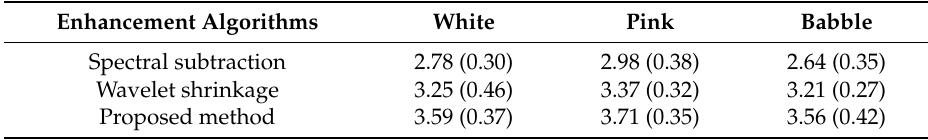
Figure 4. The time-domain waveforms and the spectrograms of the radar speech “1-2-3-4-5-6”. ( a , e ) are the original radar speech; ( b , f ) are enhanced speech obtained by the spectral subtraction; ( c , g ) are enhanced speech obtained by the wavelet shrinkage; ( d , h ) are enhanced speech obtained by the proposed algorithm. Table 1. Comparison of the results of averaged MOS with three types of noise at a SNR of 5 dB. The numbers in the brackets represent standard deviation for these mean opinion scores.